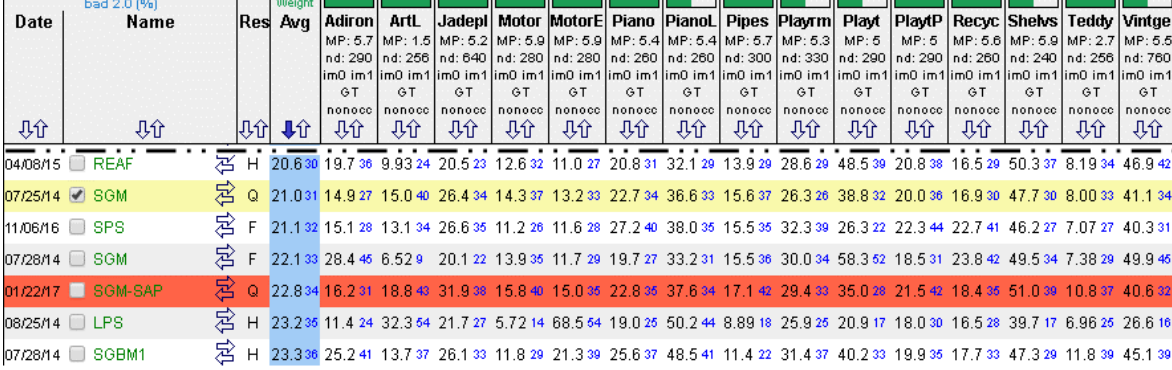
Figure 2. Results from the Middlebury evaluation platform for the training images of the 2014 dataset. The results of the self- adjusting penalty method (SGM-SAP) are highlighted in red.